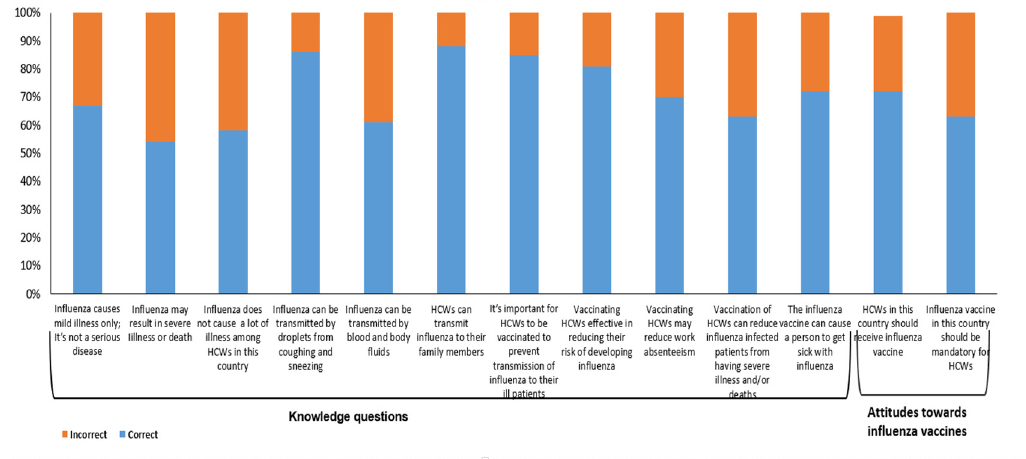
Figure 5. Frequency of knowledge responses and attitudes towards influenza vaccine amongst healthcare workers (HCWs) for the 2018–2019 season, n = 390.